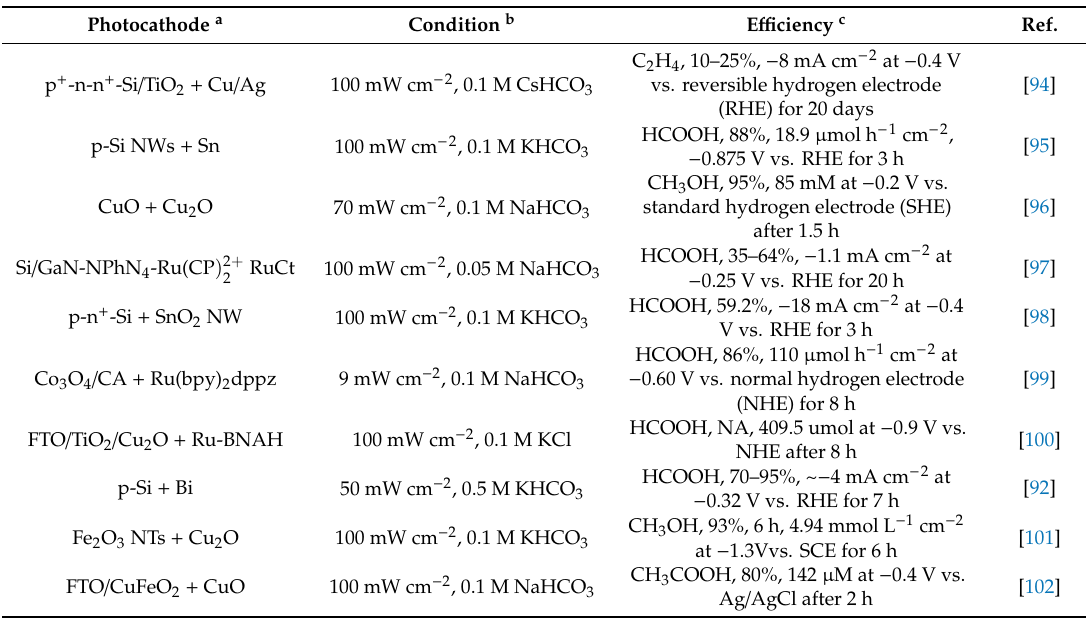
Table 1. Performance comparison of di ff erent photoelectrochemical CO 2 reduction systems from recent